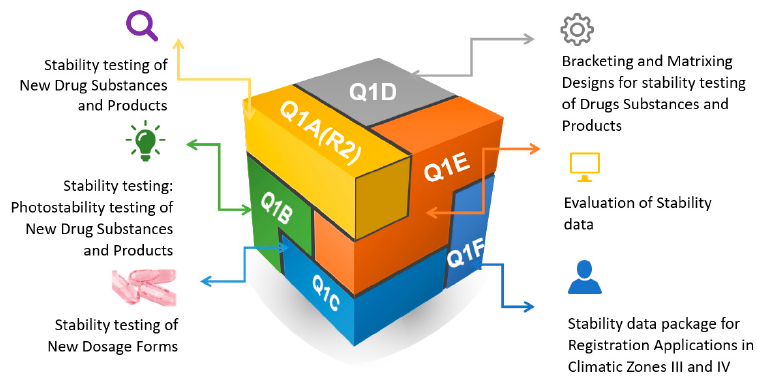
Figure 1. ICH codes and